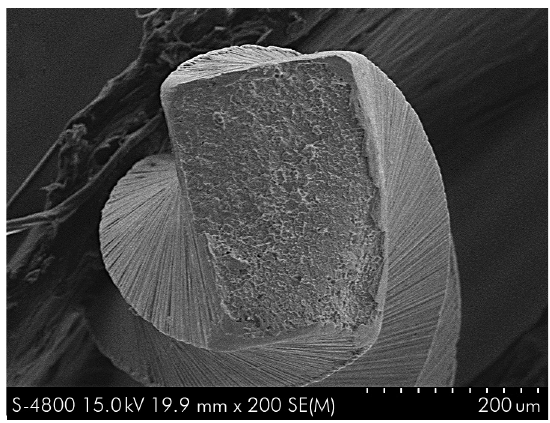
Figure 5. Scanning electron micrographs of the cross surface of the fractured ProTaper Next files from a 60° canal.